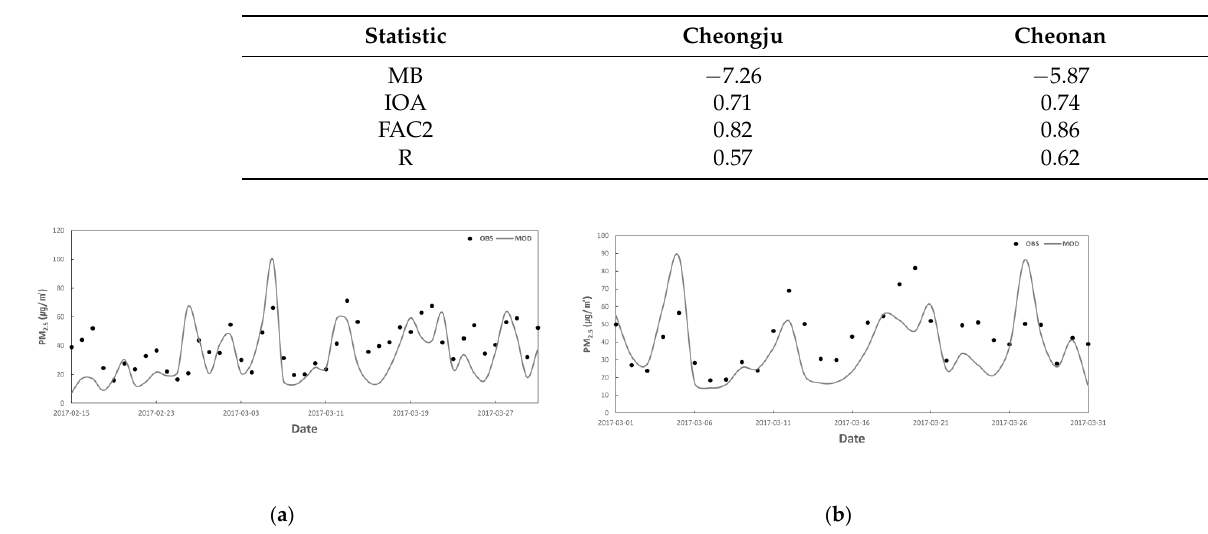
Figure 8. Time series of observed and simulated PM 2.5 concentrations in ( a ) Cheongju and ( b ) Cheonan . Table 8. Observed and simulated monthly mean PM 2.5 at Cheongju station in Chungbuk province and Cheonan station in Chungnam province . Mean (µg/m 3 )